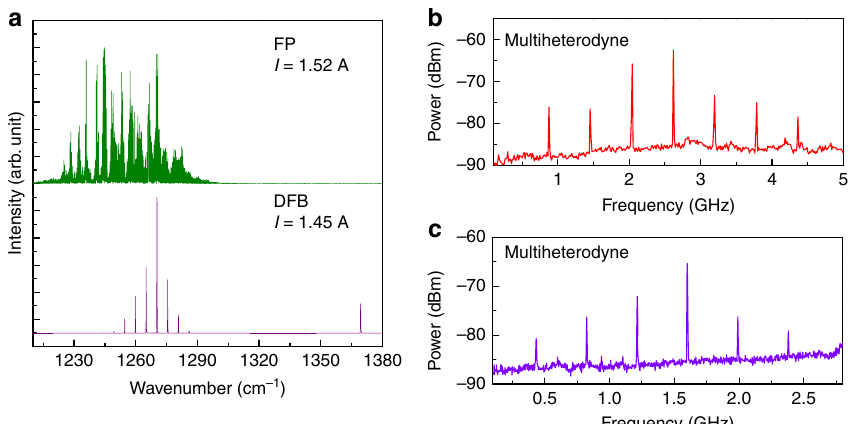
Fig. 3 Multi-heterodyne characterizations based on the DFB and FP QCL combs. a Lasing spectrum of the FP comb at 1.52 A and the DFB comb at 1.45 A recorded with the FTIR, respectively. Multi-heterodyne beating of the FP comb at 1.52 A and the DFB comb at 1.45 A ( b ), and the DFB comb at 1.55 A ( c